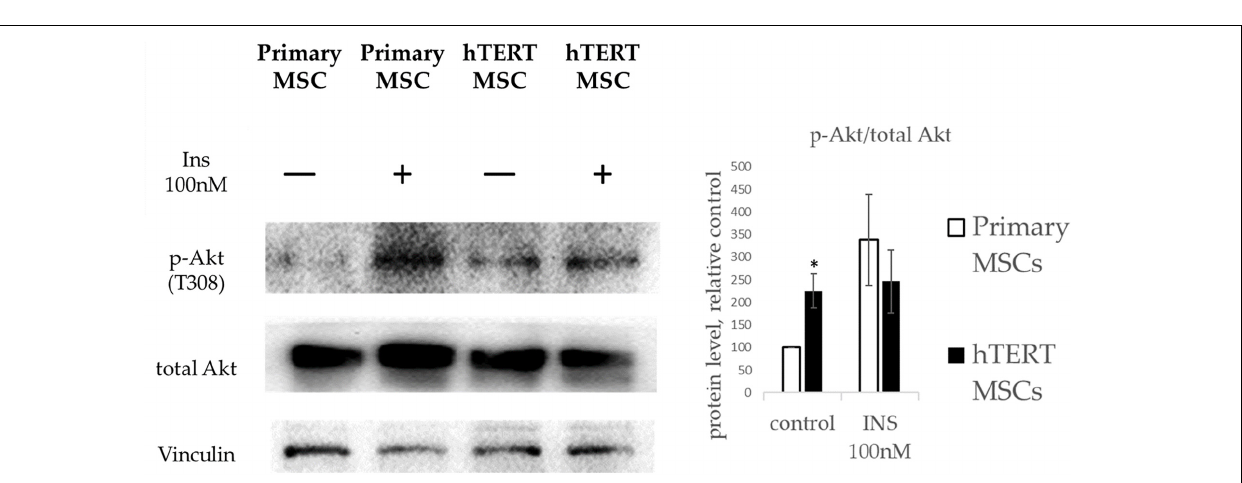
FIGURE 5 | Insulin-dependent Akt phosphorylation in primary MSC and hTERT-MSC. P-Akt levels in cells are normalized to p-Akt levels in untreated primary MSCs (control). Results are presented as mean ± SD, n = 4 independent experiments on primary MSCs from four different donors. *Mann–Whitney U test, p <